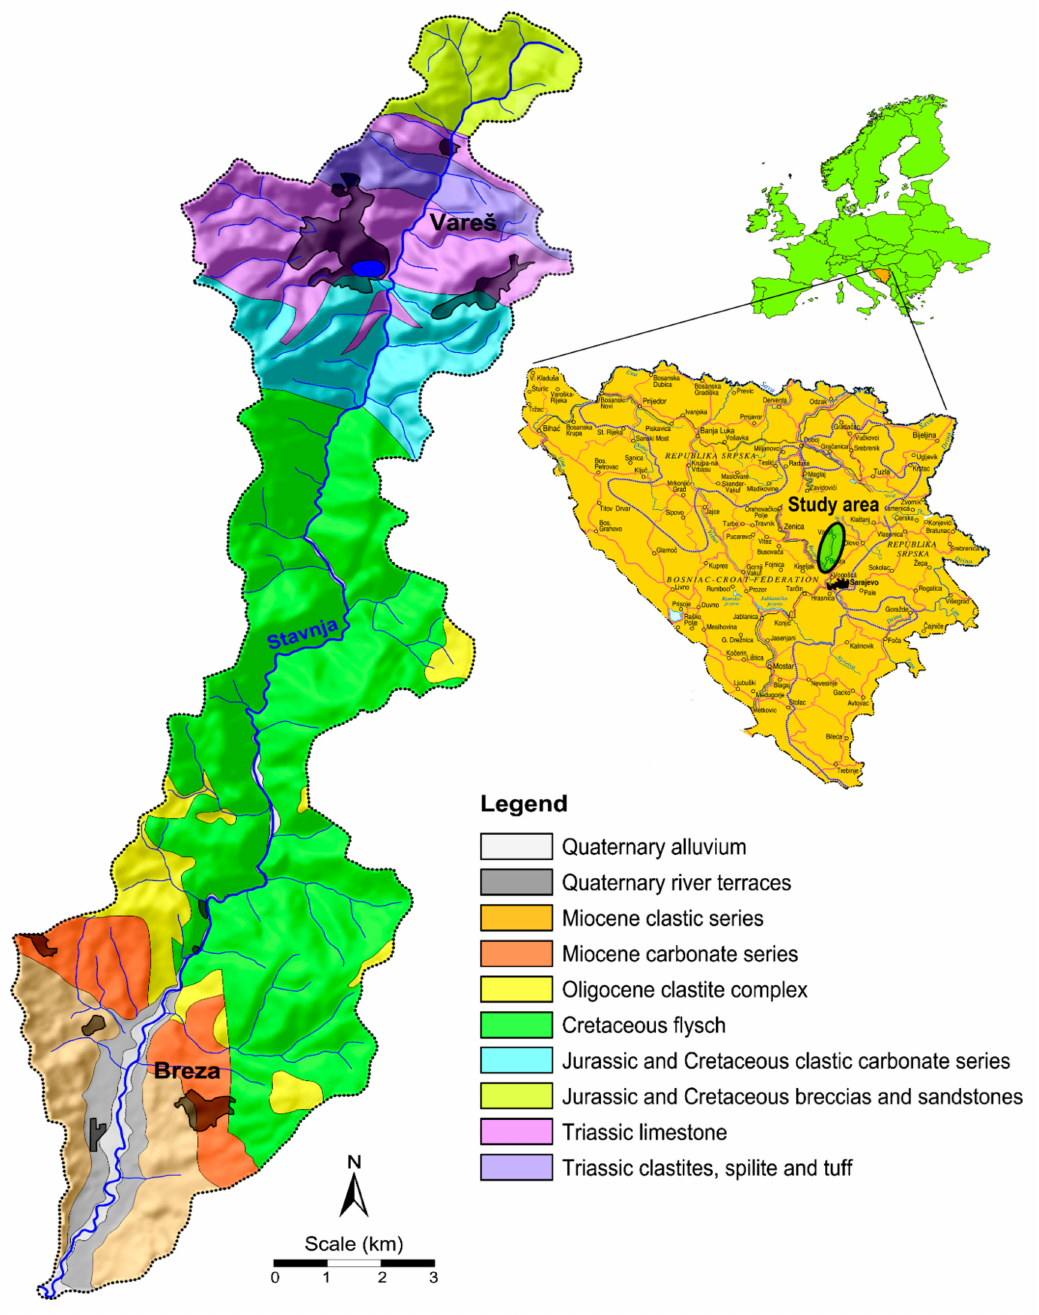
Figure 1. Location of the study area and isolated lithological